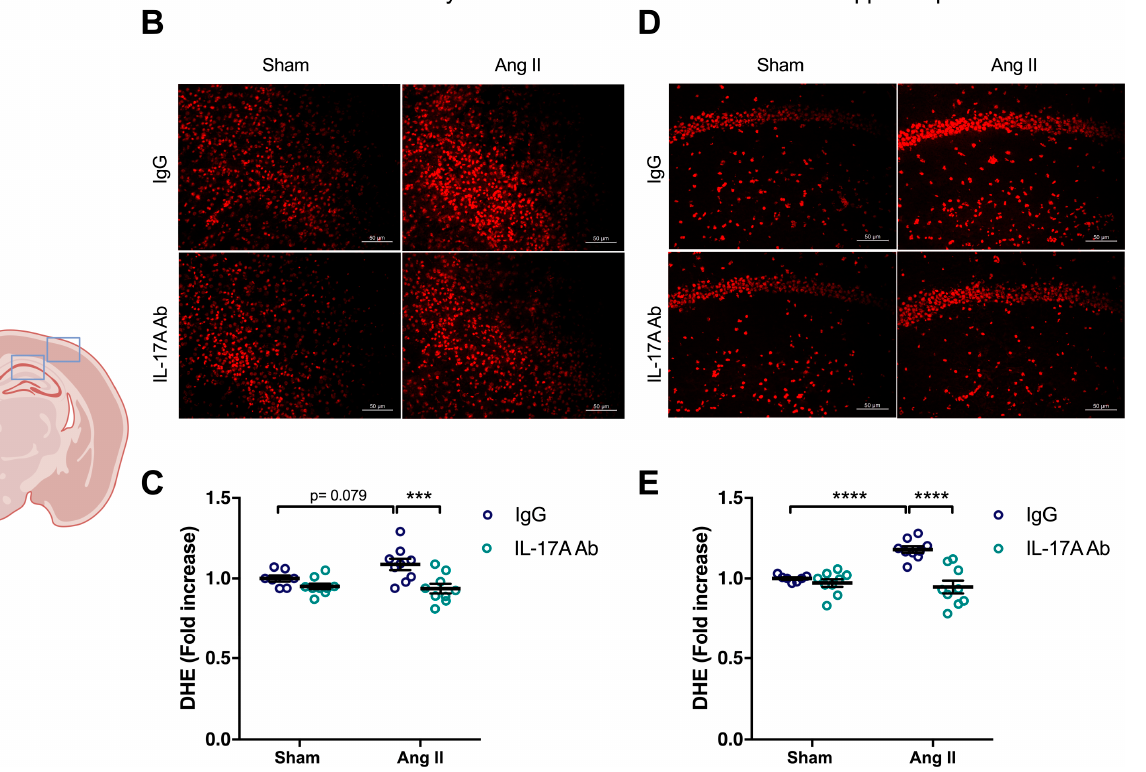
Figure 3. IL-17A neutralization prevents Ang II-induced oxidative stress production . Superoxide anion production quantified using dihydroethidium fluoromicrography (DHE) in C57BL/6 male mice treated with an IL-17A Ab or control mouse IgG antibody (0.5 μ g/ μ L per mouse every 4 days, i.p.). This administration started at day 0 of Ang II (600 ng/kg/min, 14 days) infusion through an osmotic minipump or sham surgery. ( A ) Scheme illustrating the acquisition area representing the somatosensory cortex (right box) and the CA1 of the hippocampus (left box). Representative micro- graphs of DHE staining in ( B ) the somatosensory cortex and ( D ) the CA1 of the hippocampus (50 μ m scale). The graphs depict the ratio of fluorescence compared to control mice in the ( C ) somatosensory cortex and ( E ) the hippocampus. Data were analyzed using an ANOVA for factorial design followed by a Bonferroni post-test. *** p < 0.001 and **** p < 0.0001; n = 7–9 per group.